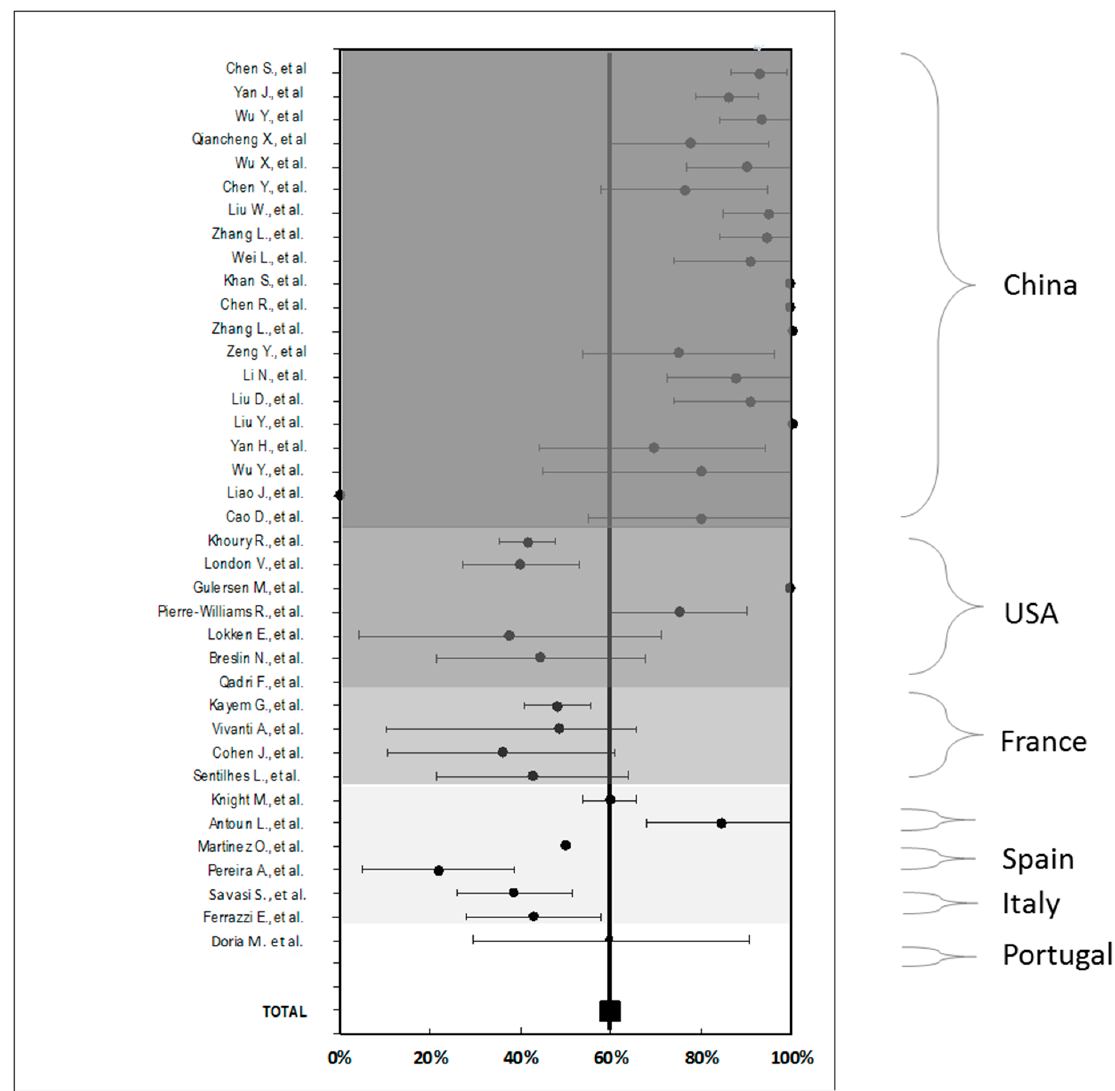
Figure 2. Percentage of C-section with 95% confidence interval observed in the studies and grouped by country.